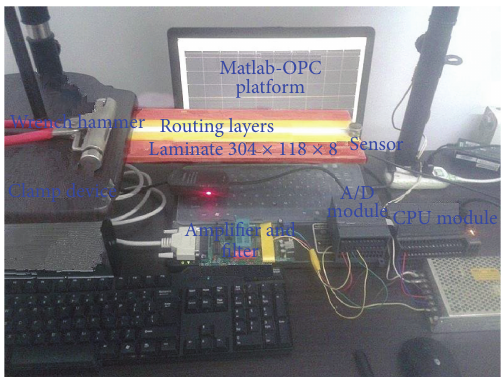
Figure 12: The experimental platform of cantilever beam.